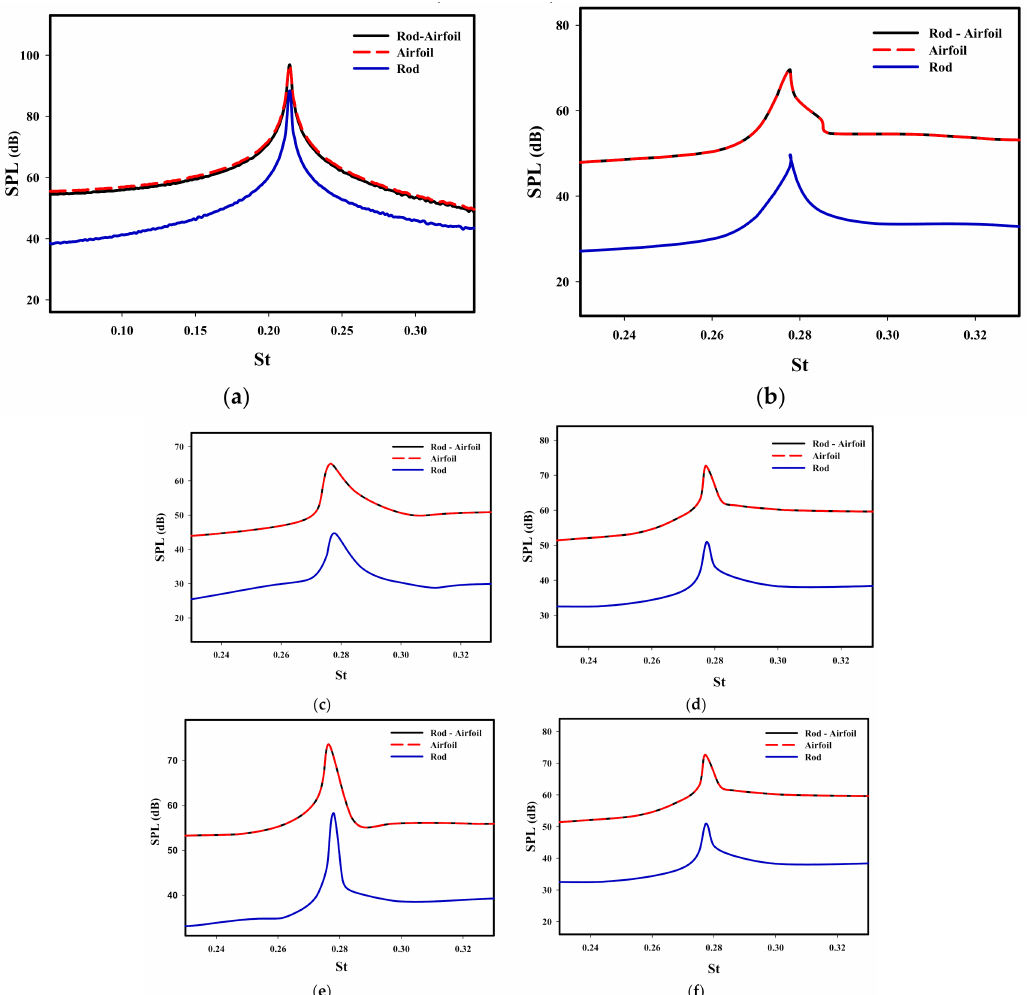
Figure 9. SPL variations recorded by altering the amount of the vibrating displacement (SPL-St): ( a ) A = 0, ( b ) A = 0.02 C,